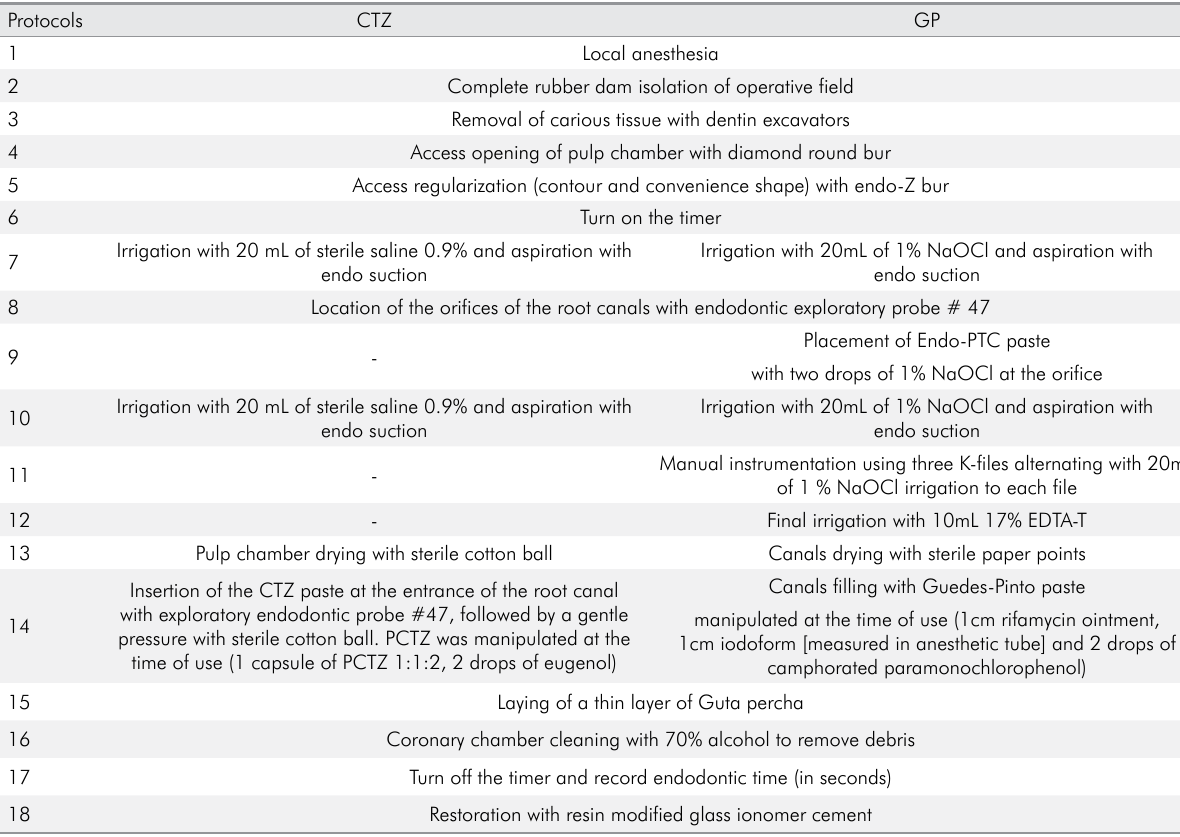
Table 1. CTZ and GP